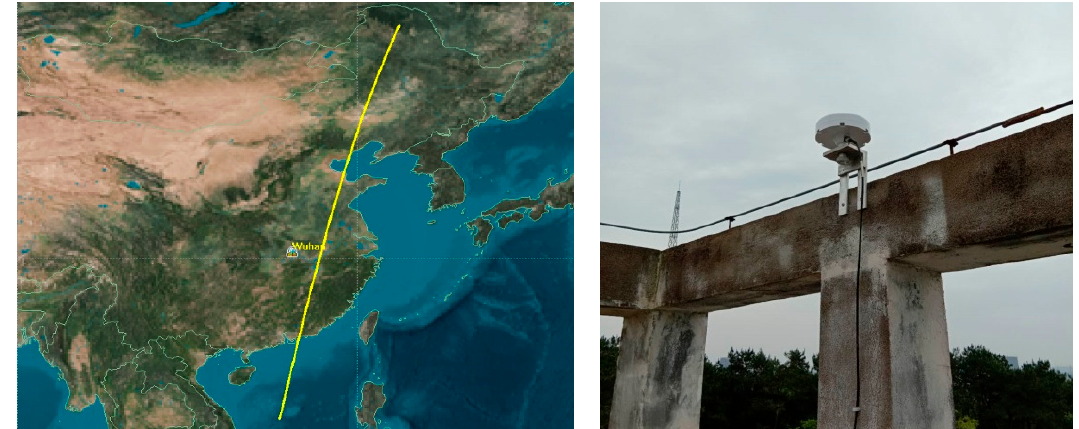
Figure 8. Luojia-1A satellite footprint ( left panel ) and the setup of the ground receivers on a rooftop structure ( right panel ).